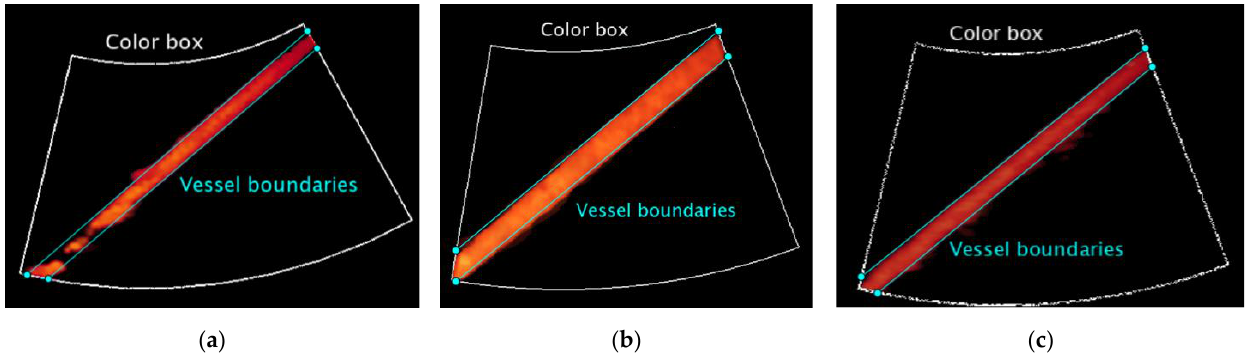
Figure 4. Straight lines approximating the upper and lower vessel boundaries used to subdivide the color box of the i -th average image for ( a ) system one, ( b ) system two and ( c ) system three equipped with convex array probes in configuration B at medium flow rate regime Q M .